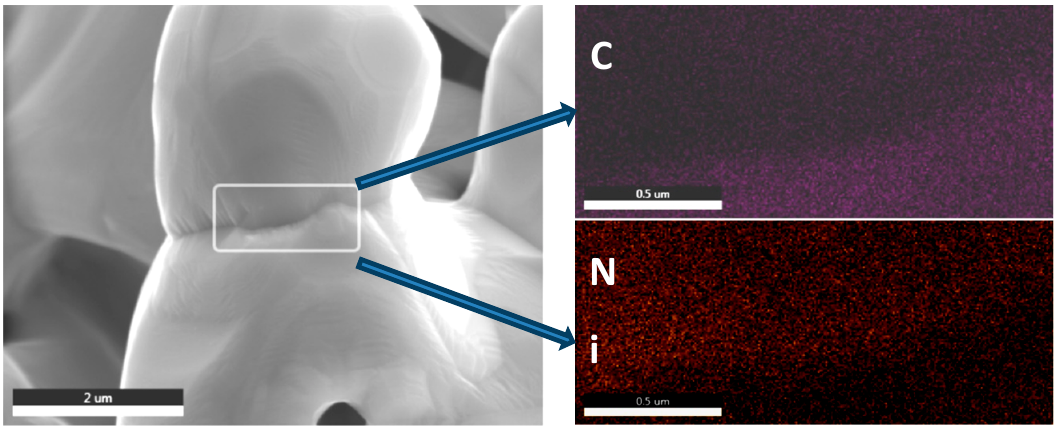
Figure 4. Mapping of C and Ni along the grain boundary of sample H1.